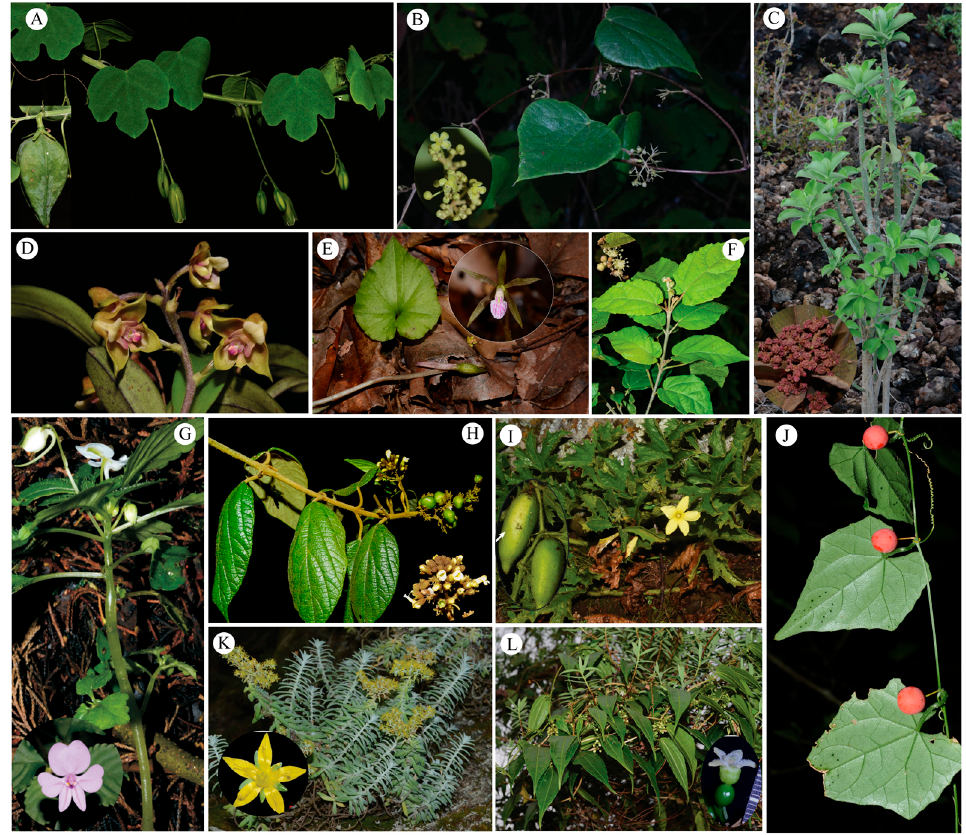
Figure 3. Some noteworthy new and recently discovered taxa found in tropical East Africa by SA- JOREC team. ( A ) Adenia angulosa G.W. Hu & Q.F. Wang, 2017; ( B ) Cissampelos keniensis Y.D. Zhou